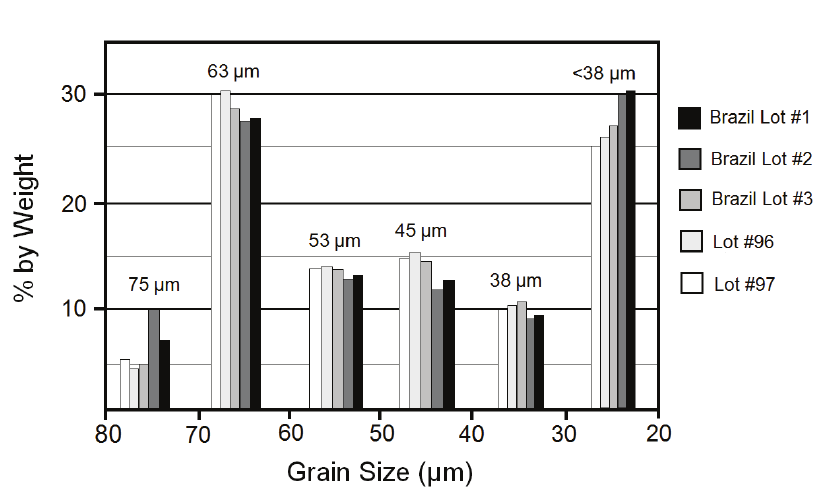
Figure 7. Grain size Table 2. OSL sensitivity for the standard and recovered material. Samples